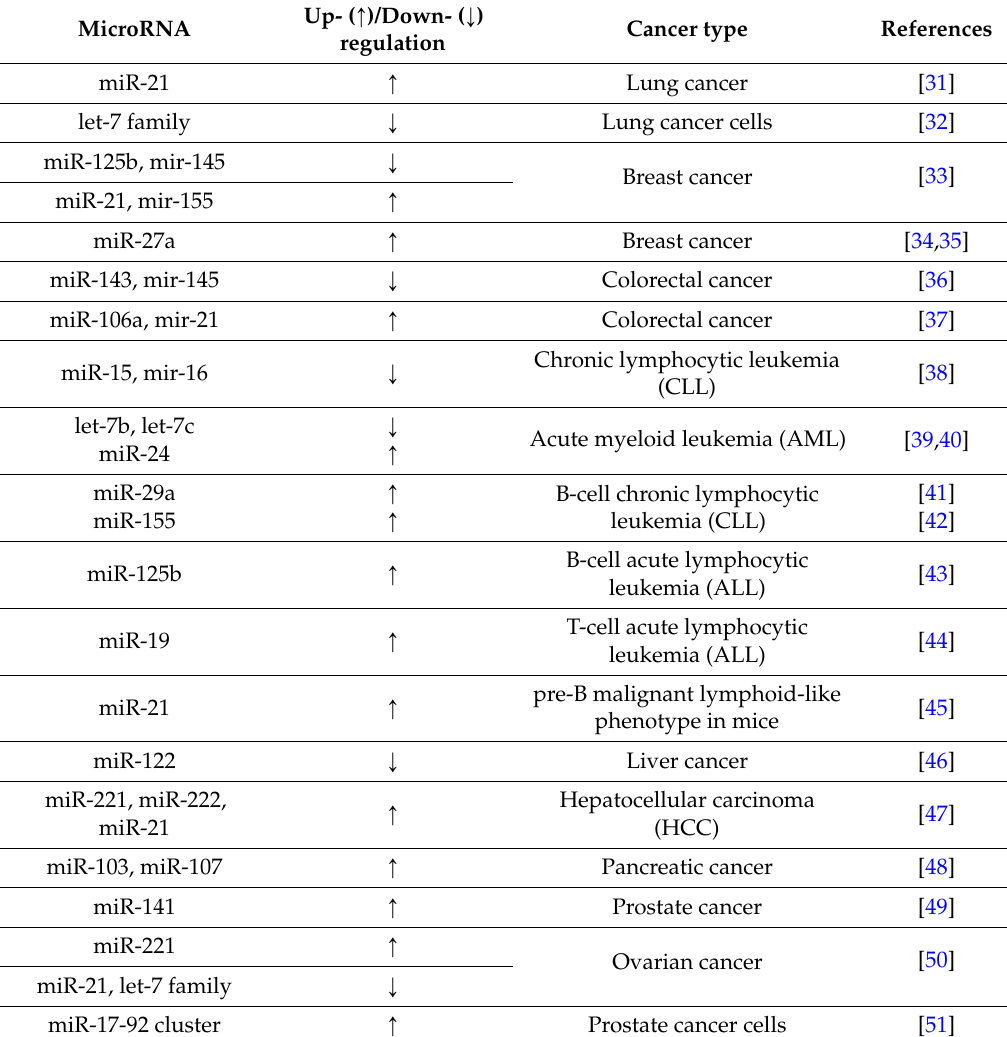
Table 1. Overview of key microRNAs associated with